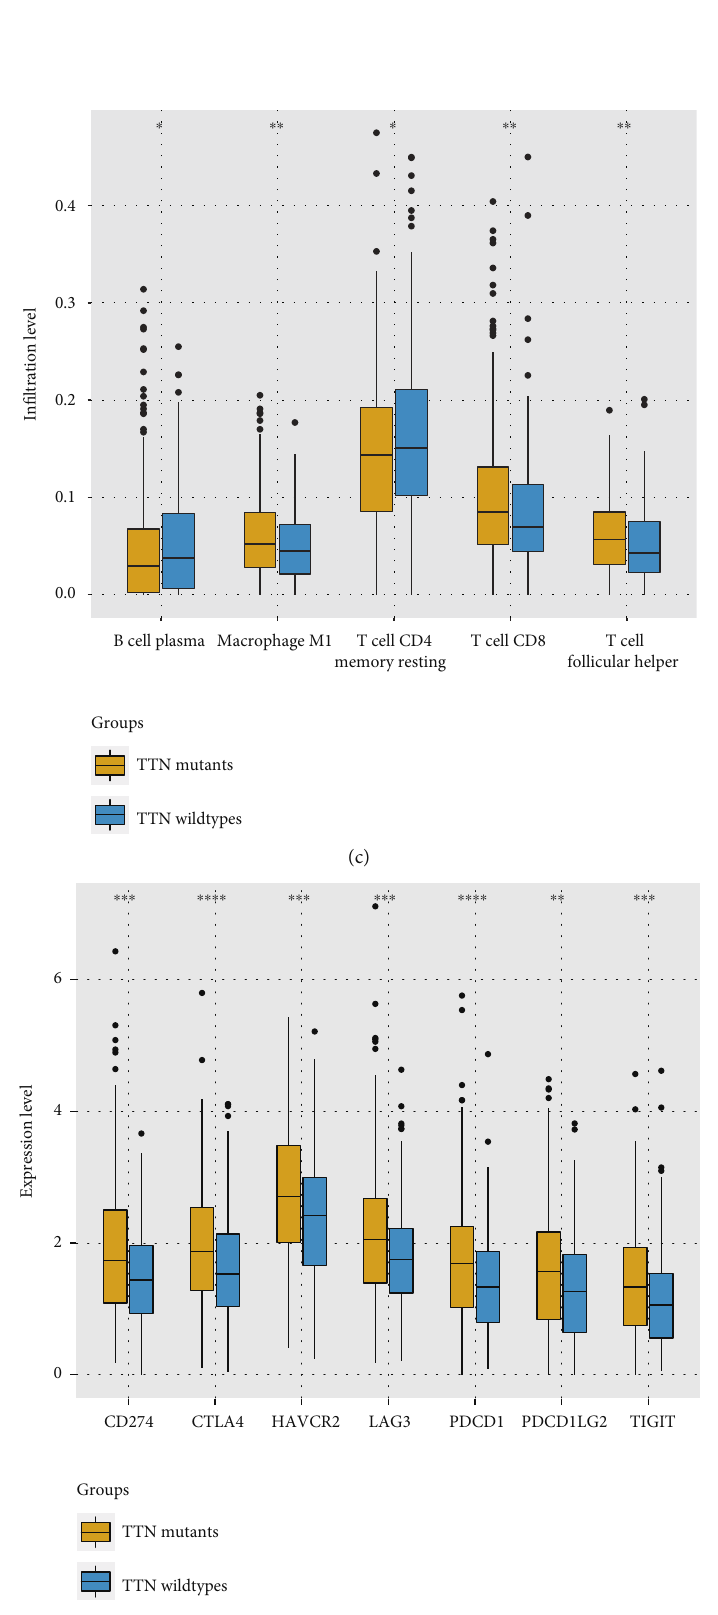
Figure 2: In fl uence of TTN mutations on the CRC immune microenvironment. (a) Sankey diagram representing the distribution of clinicopathological features in TTN-mutant and wild-type tumors; (b) immune in fi ltration status of TTN-mutant and wild-type tumors; (c) comparison of immune in fi ltration levels between TTN-mutant and wild-type tumors; (d) comparison of immune checkpoint expression levels in TTN-mutant and wild-type